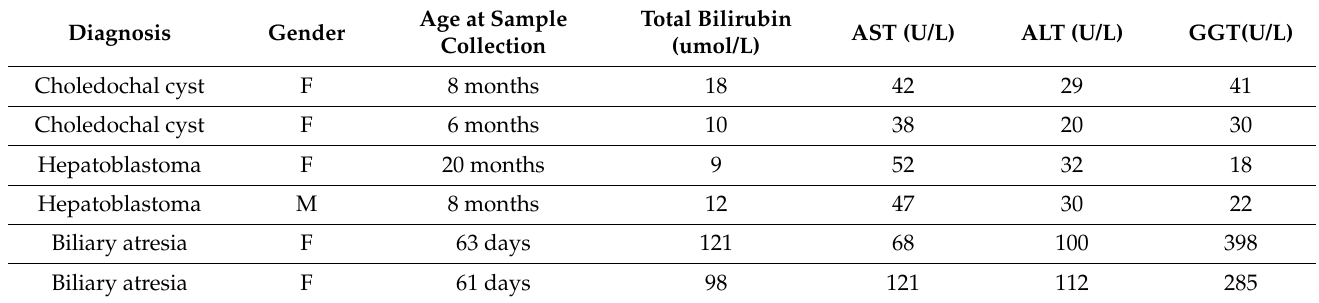
Table 1. The diagnosis and liver function of patients whose liver samples were